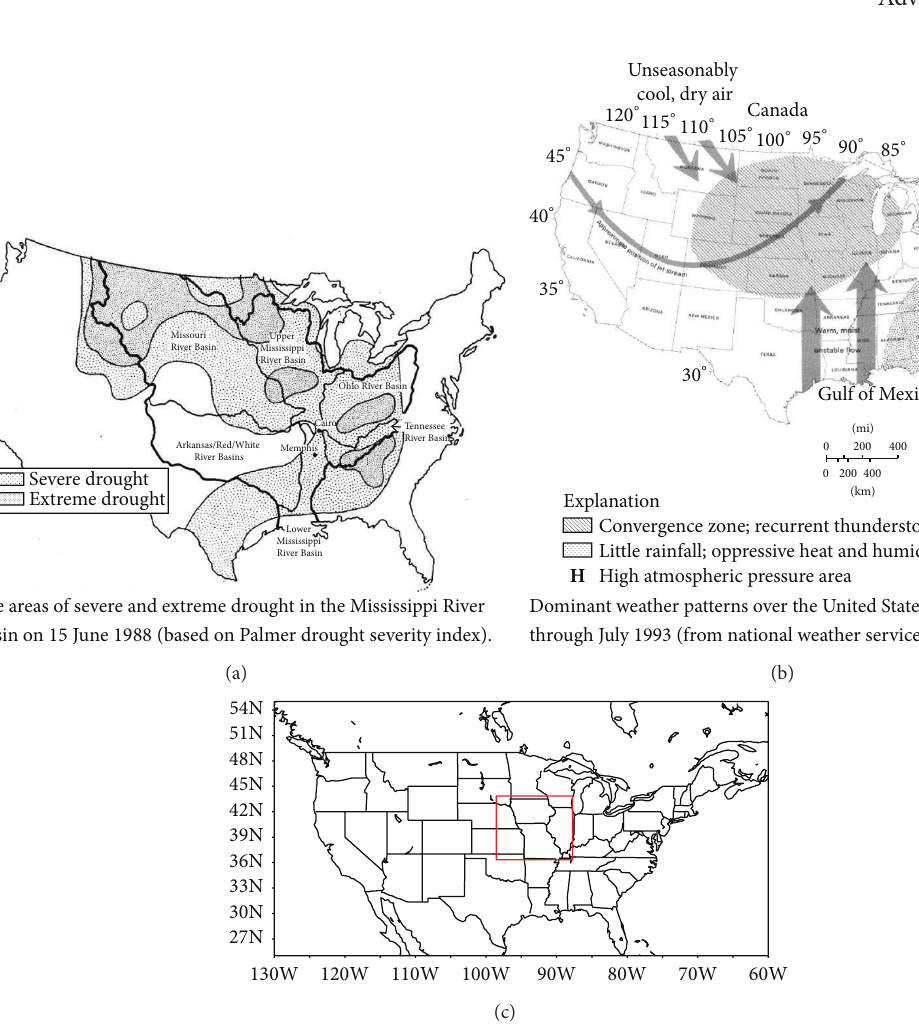
Figure 1: (a) Schematic of 1988 drought from Changnon [2]. (b) Schematic of 1993 flood from Wahl et al. [3]. (c) Area used to tabulate storm-rainfall index (red